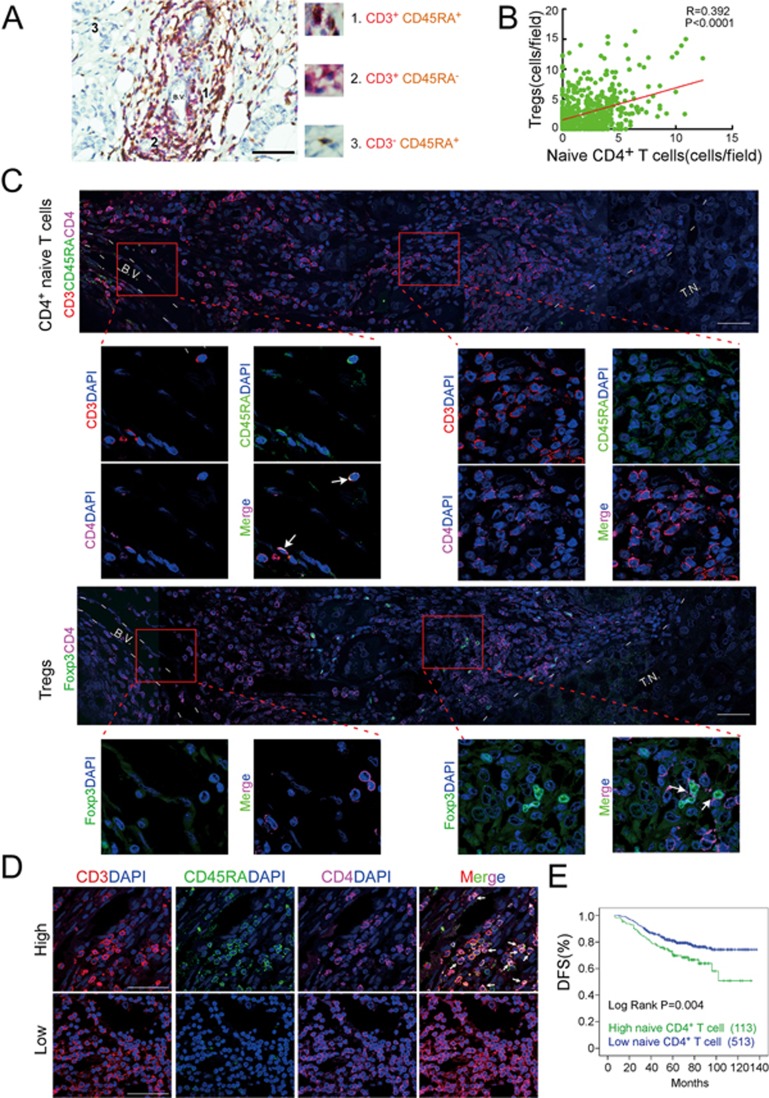
Naive CD4+ T cell abundance within breast tumors is associated with increased numbers of Tregs and poor patient prognosis. (A) IHC staining of CD3 (red) and CD45RA (brown) in a representative breast cancer sample. Naive T cells were defined as CD3+CD45+ cells. Scale bar, 50 μm. (B) Correlation of TI naive CD4+ T cell numbers and TI Treg numbers in breast cancer samples (n = 626, Pearson correlation coefficient R and P-value are shown). (C) Representative immunofluorescent staining for naive T cells (CD3 (red), CD45RA (green) and CD4 (purple); upper panels) or Tregs (Foxp3 (green) and CD4 (purple); lower panels) in serial sections from a human breast cancer sample. Arrows indicate CD3+CD4+CD45RA+ naive CD4+ T cells (upper) and CD4+Foxp3+ Tregs (lower). Scale bar, 50 μm. The localization of naive CD4 T cells and Tregs relative to the perivascular space or tumor parenchyma for 626 tumor samples is provided in Supplementary information, Figure S3C. (D) Representative immunofluorescent staining of CD3 (red), CD45RA (green), CD4 (purple) and DAPI (blue) in breast cancer samples with high (upper panel) or low (lower panel) number of naive CD4+ T cells, which are indicated by arrows. Scale bar, 50 μm. (E) Kaplan-Meier survival curve of breast cancer patients with low and high numbers of TI naive CD4+ T cells. BV, blood vessel; TN, tumor nest.